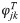
Evaluation of kinship estimators.Observed accuracy for two existing kinship coefficient estimators is illustrated in our admixture simulation and contrasted to the nearly unbiased estimates of our new estimator. Plots show n = 1000 individuals along both axes, and color corresponds to φjkT between individuals j ≠ k and to fjT along the diagonal (fjT is in the same scale as φjkT for j ≠ k; plotting φjjT, which have a minimum value of 12, would result in a discontinuity in this figure). (A) True kinship matrix. (B) Estimated kinship using our new estimator in Eqs (34) and (37) from simulated genotypes recovers the true kinship matrix with high accuracy. (C) Theoretical limit of φ^jkT,std in Eq (19) as the number of independent loci goes to infinity demonstrates the accuracy of our bias predictions under the kinship model. (D) Standard kinship estimates φ^jkT,std given by Eq (18) from simulated genotypes are downwardly biased on average and distorted by pair-specific amounts. (E) Theoretical limit of the Weir-Goudet kinship estimator given by Eq (38). (F) Weir-Goudet kinship estimates from the same simulated genotypes agree with our calculated limit.